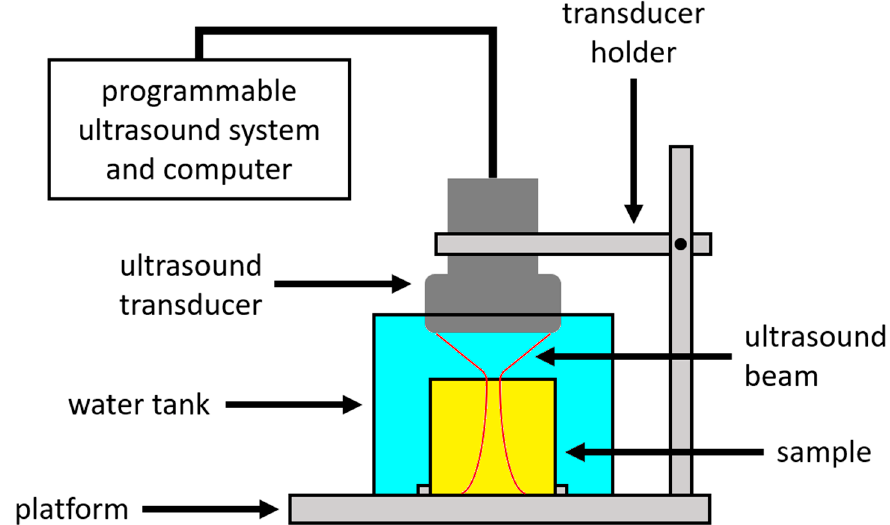
Figure 1. In the future experiment, the experimental setup will consist of a programmable ultrasound system with a phased array ultrasound transducer. The sample is secured on the bottom of the water tank.